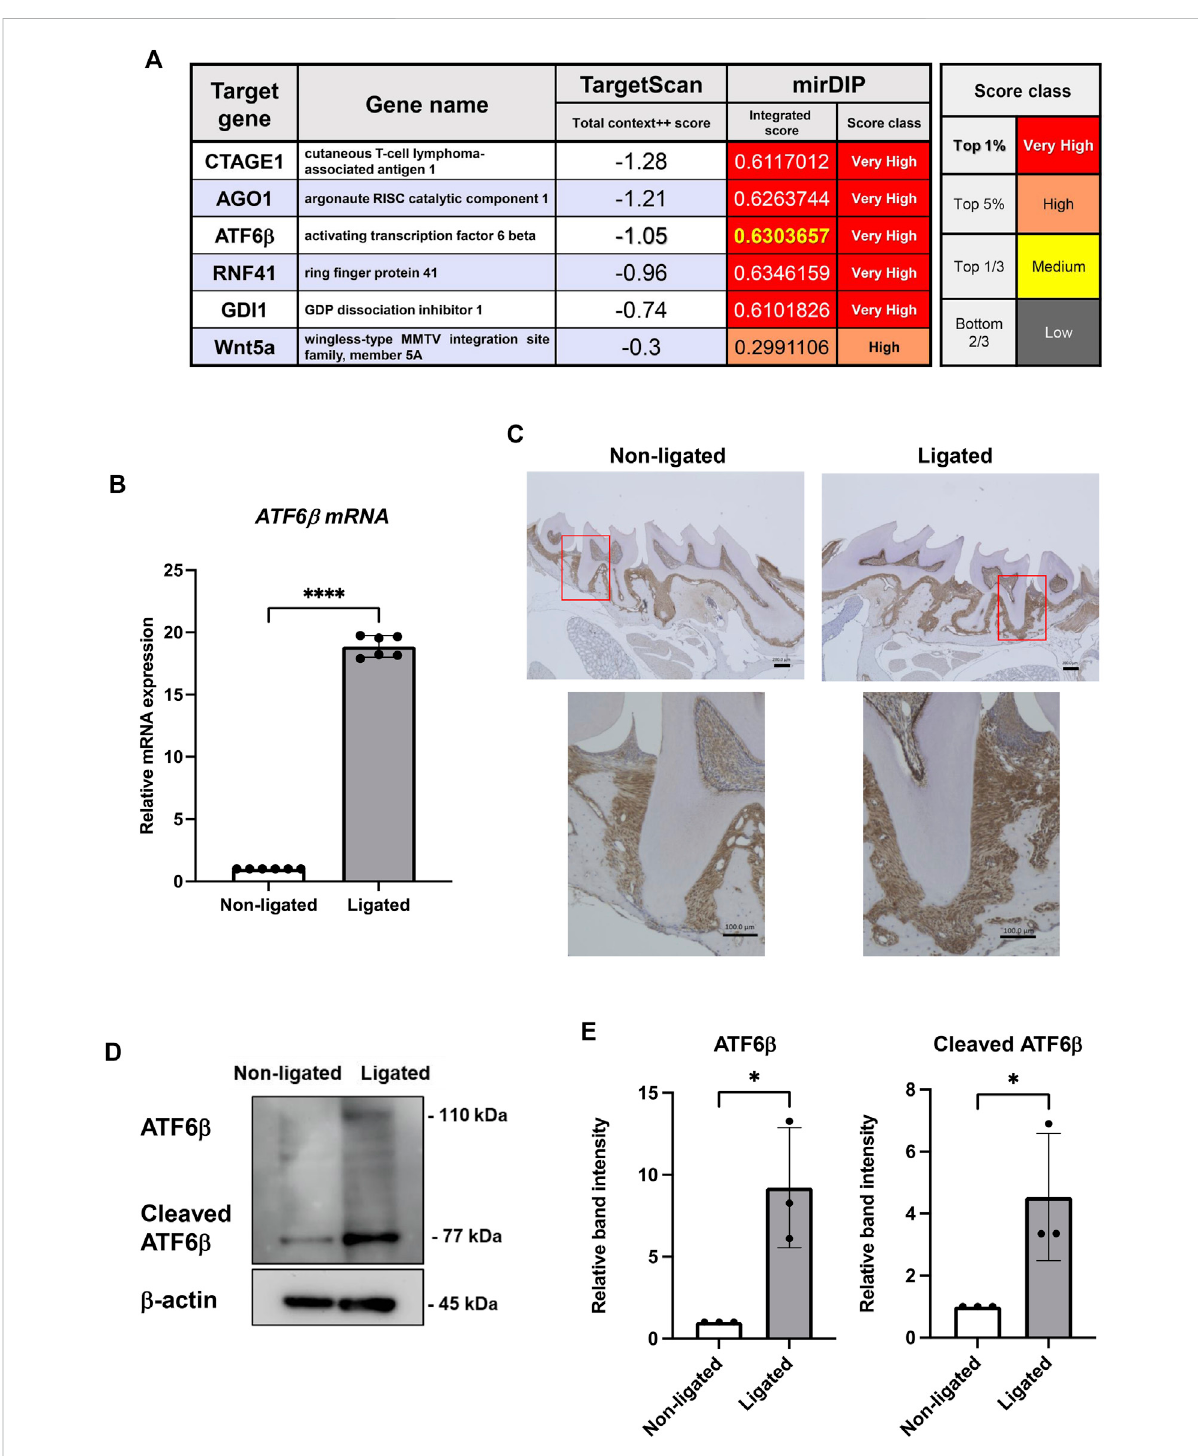
Expression levels of the activating transcription factor ( ATF )- 6 β , a novel microRNA (miR)-1260b-targeting gene, are upregulated in the mice periodontal model. (A) TargetScan and miRDIP databases were used to identify novel top target genes of miR-1260b. (B – E) Enhanced expression of ATF6 β in ligature-induced mice periodontal model. A 5-0 silk ligature was tied around the maxillary second molar in C57BL/6 mice for 7 days. (B) Relative mRNA expression of ATF6 β in mice gingival tissue ( n = 6). (C) Immunohistochemical staining of ATF6 β in mice periodontal tissue. (D) Western blotting analysis revealed the expression levels of full-length and cleaved ATF6 β in mice gingiva, and the relative expression was measured ( n = 3). β -actin was used as the control. (D) . * p < 0.05, **** p < 0.0001. Error bars represent the mean ± standard deviation (SD). The signi fi cance of differences between groups was determined using one-way Tukey ’ s